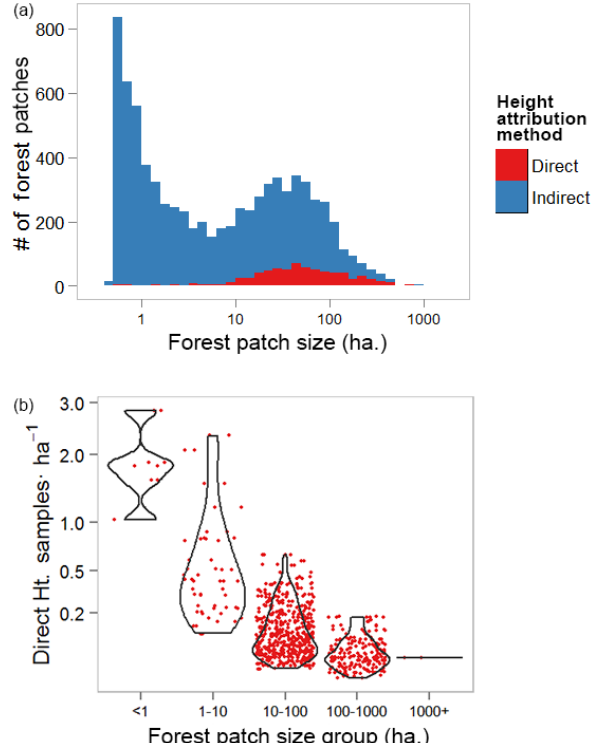
Figure 3. (a) The distributions of forest patch size in hectares ac- cording to height attribution method. (b) The distribution of direct height sample density (shown as violin plots) for each forest patch size group, overlain with dots representing individual patches